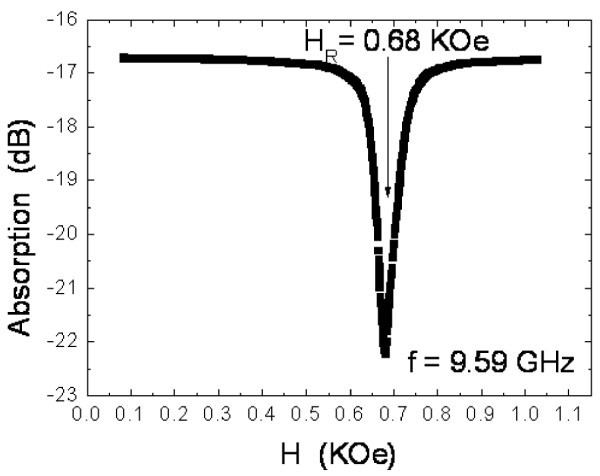
Ferromagnetic resonance of the Co40Fe40B20 film with the microwave frequency f = 9.6 GHz. HR is the resonance field.